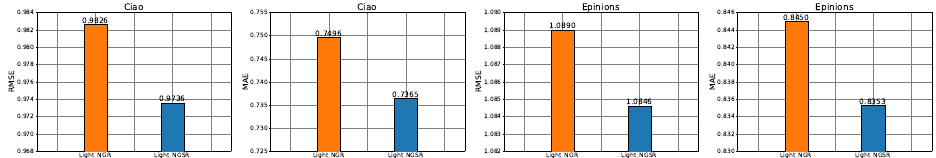
Figure 3. Performance comparison between Light_NGSR and